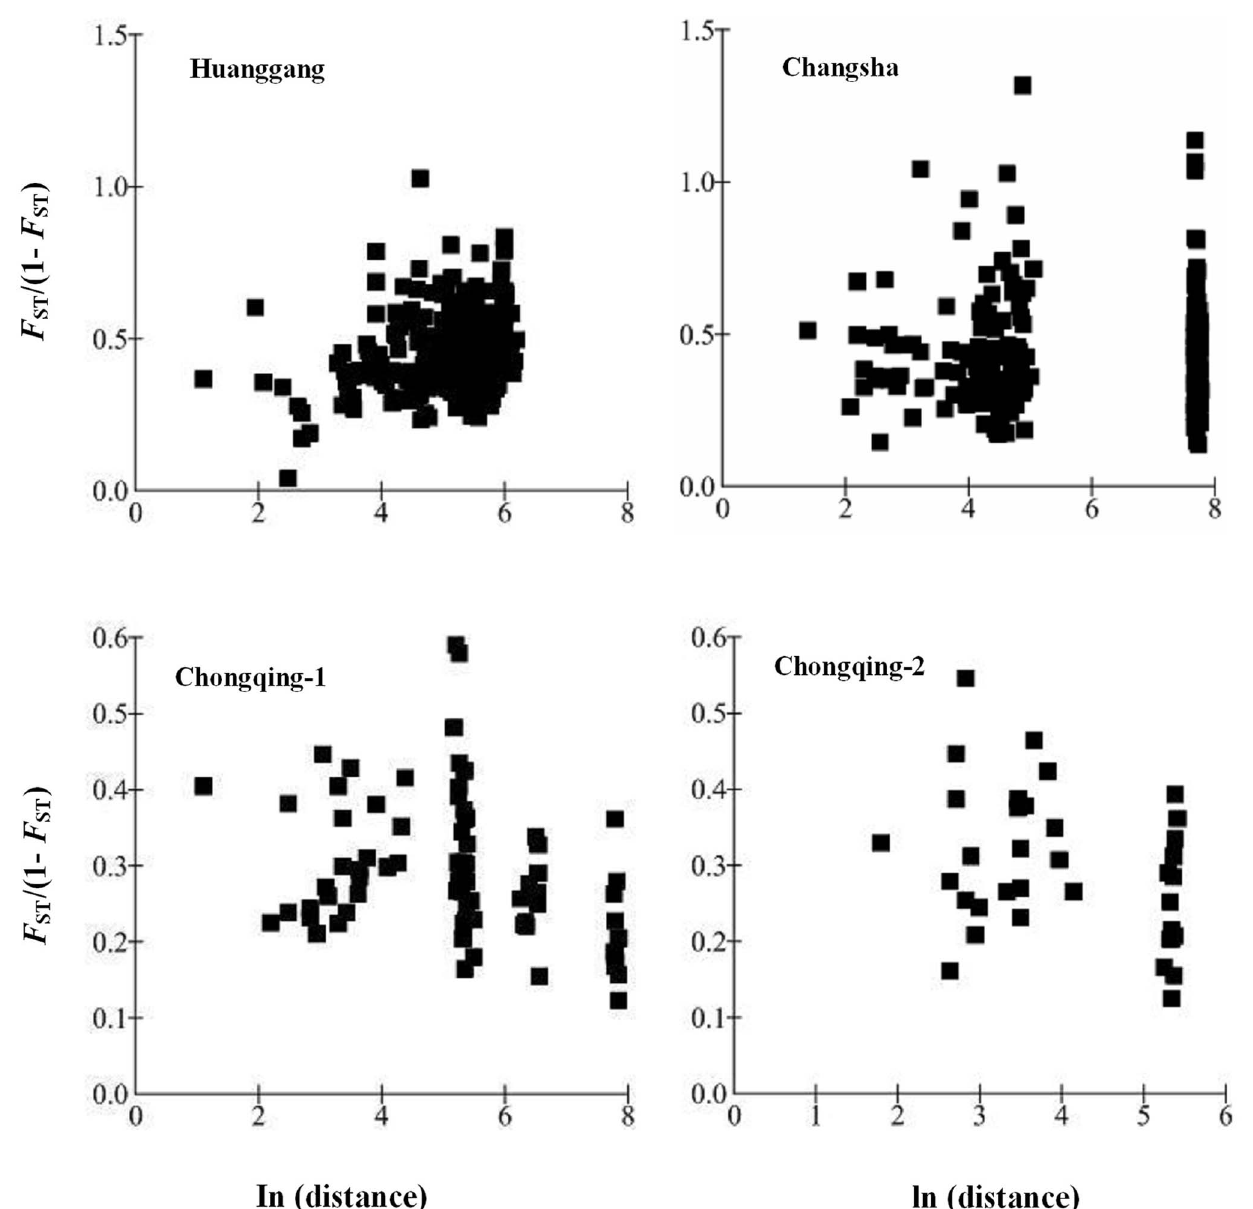
Figure 3. Isolation by distance analysis for the colonies within each population. The correlation coefficient was significant for the relationship for Huanggang population ( r =0.2245, P =0.0014, Mantel test). The correlation coefficients were not significant for either of the relationships ( r =0.0130, 2 0.3284 and 2 0.3426, P =0.4462, 0.9654 and 0.9015, Mantel test, for Changsha, Chongqing-1 and Chongqing-2 population, respectively). doi:10.1371/journal.pone.0069070.g003 (31%) in the Chongquing-1 population and the most mixed family colonies (9%) in the Chongquing-2 population (Table 2). The F -statistics and relatedness values estimated from the worker genotypes in each population are shown in Table 2, along with values derived from simulations for different breeding systems computed in previous studies [20,21,35]. Mean observed F IT and F IC values of simple family colonies in Changsha were significantly higher than the expected values in outbred unrelated pairs (Table 2, case A1) (all P , 0.05, one sample t test), but not significantly different from the expected F IT and F IC values for